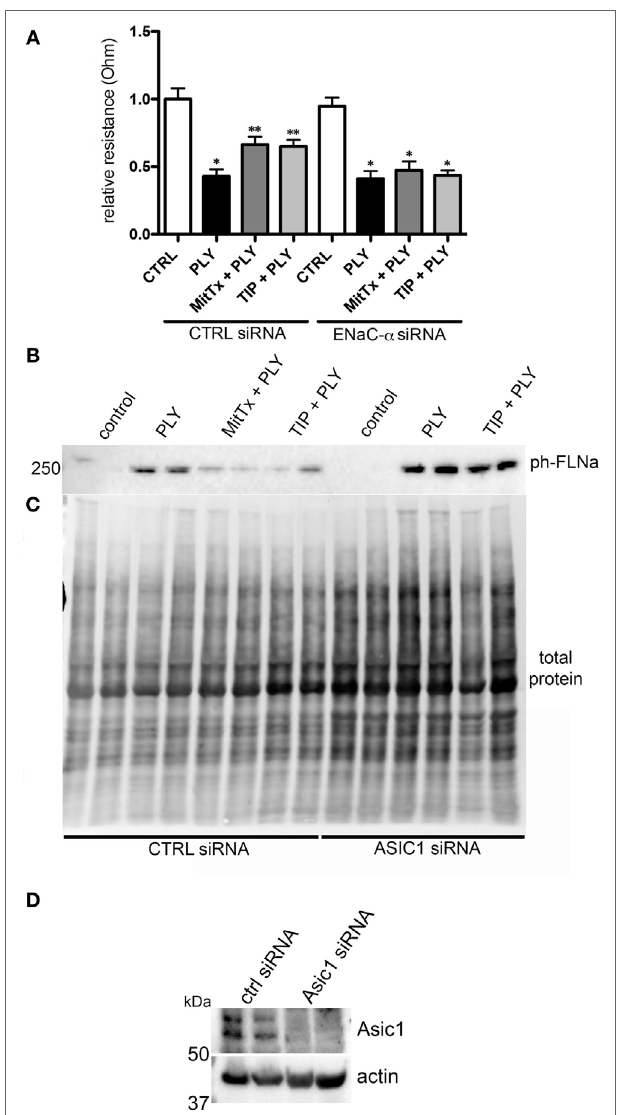
FigUre 5 | (a) Transendothelial resistance (measured in electrical cell-substrate impedance sensing 1600R) in human lung microvascular endothelial cells (HL-MVEC), transfected with scrambled siRNA or epithelial sodium channel (ENaC)- α siRNA and treated for 30 min with 60 ng/ml of PLY, in the presence or absence of TIP peptide (50 µg/ml) or MitTx (20 nM) ( n = 3, SEM) (* p < 0.05 versus ctrl, ** p < 0.05 versus PLY). (B) Representative western blot and quantification of phospho- over total protein ratio of PLY (60 ng/ml)-mediated filamin A (FLN-A) phosphorylation in HL-MVEC after 20 min. Cells were either pretreated with TIP peptide (50 µg/ml) or MitTx (20 nM) for 15 min. (c) Representative stain-free blot showing total protein transferred to the nitrocellulose membrane. (D) siRNA-mediated acid-sensing ion channel 1a (ASIC1a) silencing in